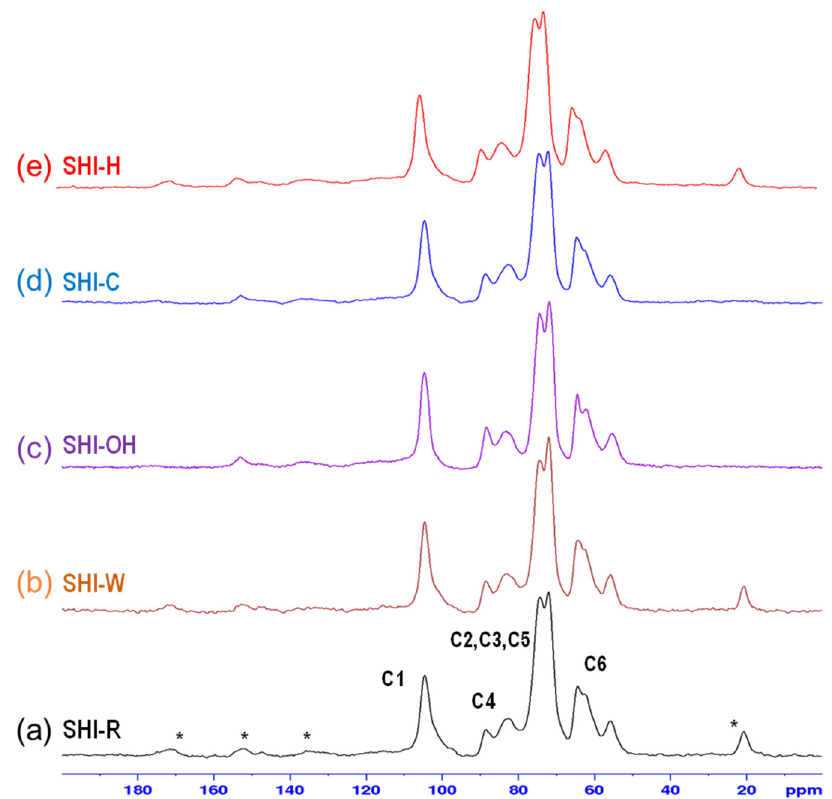
Figure 7. CPMAS NMR spectra for untreated SHI-R ( a ) and treated shives SHI-W, SHI-OH, SHI-C and SHI-H ( b – e ). The NMR spectra show the C1–C6 peaks of the glucopyranose unit in the range 50–110 ppm and other peaks (marked with an *) due to residual lignin and/or impurities.